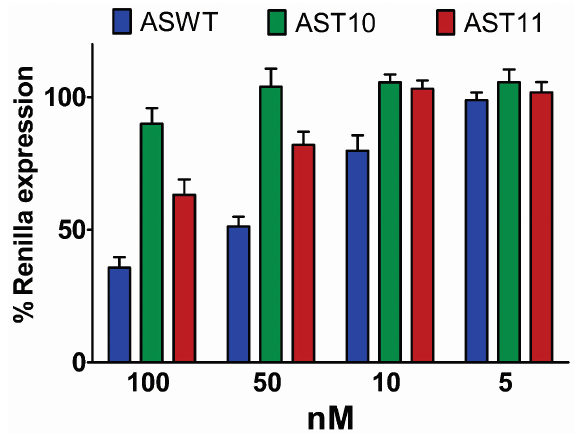
Figure 6. Plot of antisense ss-siRNAs activities of natural ( ASWT ) and T L -modified ss-siRNAs ( AST10 and AST11 ). Variable amounts of siRNAs (100 nM, 50 nM, 10 nM and 5 nM) were co-transfected with psiCHECK2 ( AS ) reporter in HeLa cells. 24 h post-transfection the luminescence were measured. n = 3 ±